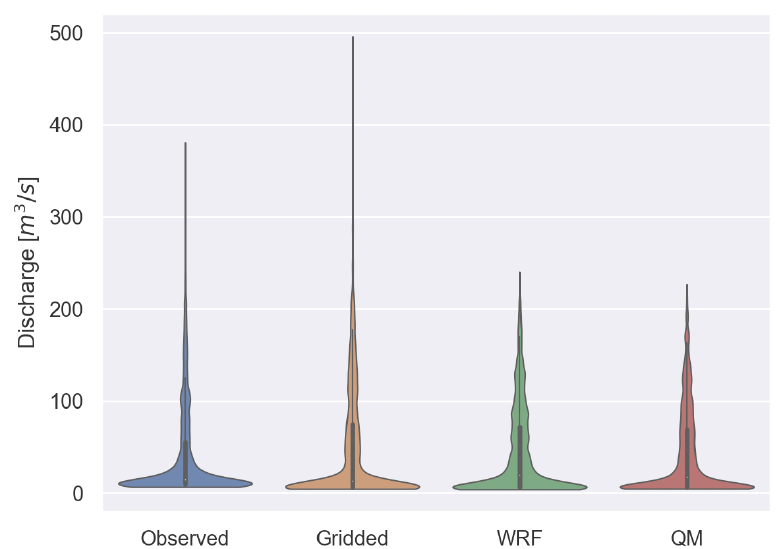
Figure 6. A comparison of the frequency distributions between the simulated discharges using different precipitation datasets (the GRIDDED precipitation, the WRF downscaled precipitation, and the QM frequency corrected precipitation data) and the observed